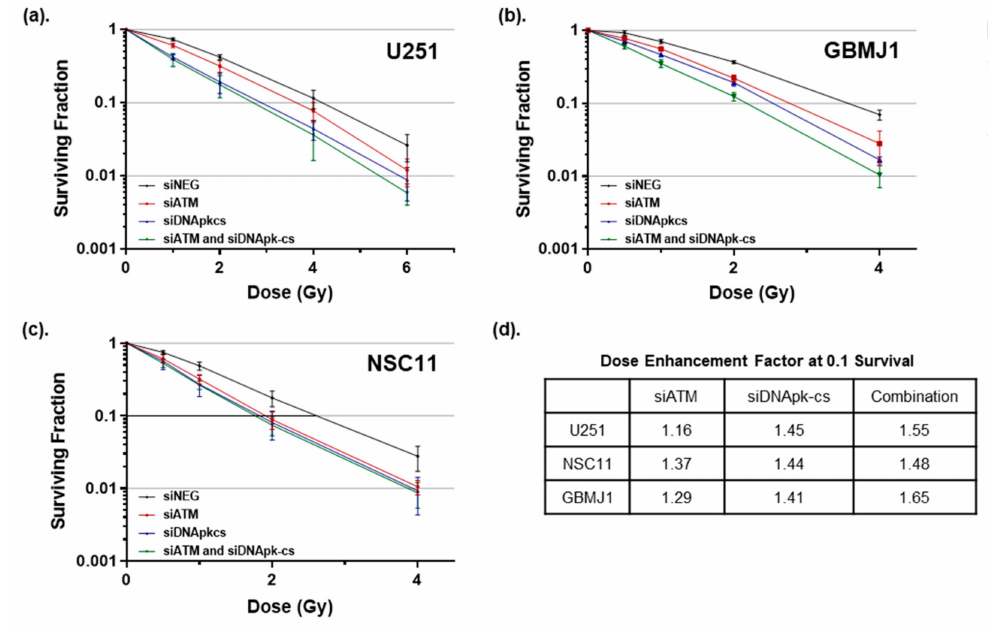
Figure 3. Clonogenic cell survival and corresponding dose enhancement factors in glioma (( a ) U251) and glioma stem cells (( b ) GBMJ1, ( c ) NSC11) after treatment with nanoparticles targeting ATM, DNApk-cs, and a combination of the two targets. Clonogenic curves are shown as the mean ± SEM of 3 independent experiments. Dose enhancement factors ( d ) were calculated at a surviving fraction of